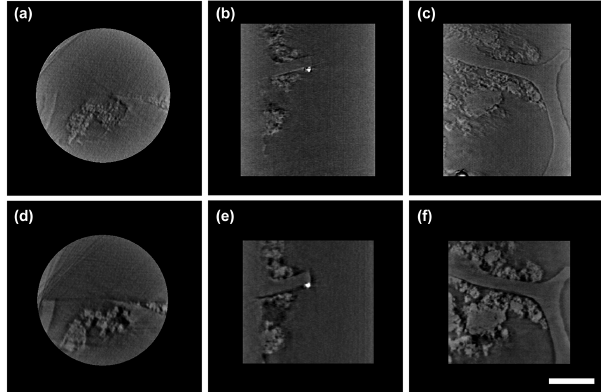
Figure 2. Three-directional orthogonal sections of laboratory-made BC and mineral nanoparticle consortium. The upper row sections were extracted from absorption contrast tomography (a, b, c) , and the lower row sections are extracted from phase contrast tomogra- phy (d, e, f) , specifically (a) and (d) are for xy plane, (b) and (e) are for yz plane, and (c) and (f) are for xz plane. The scale bar is